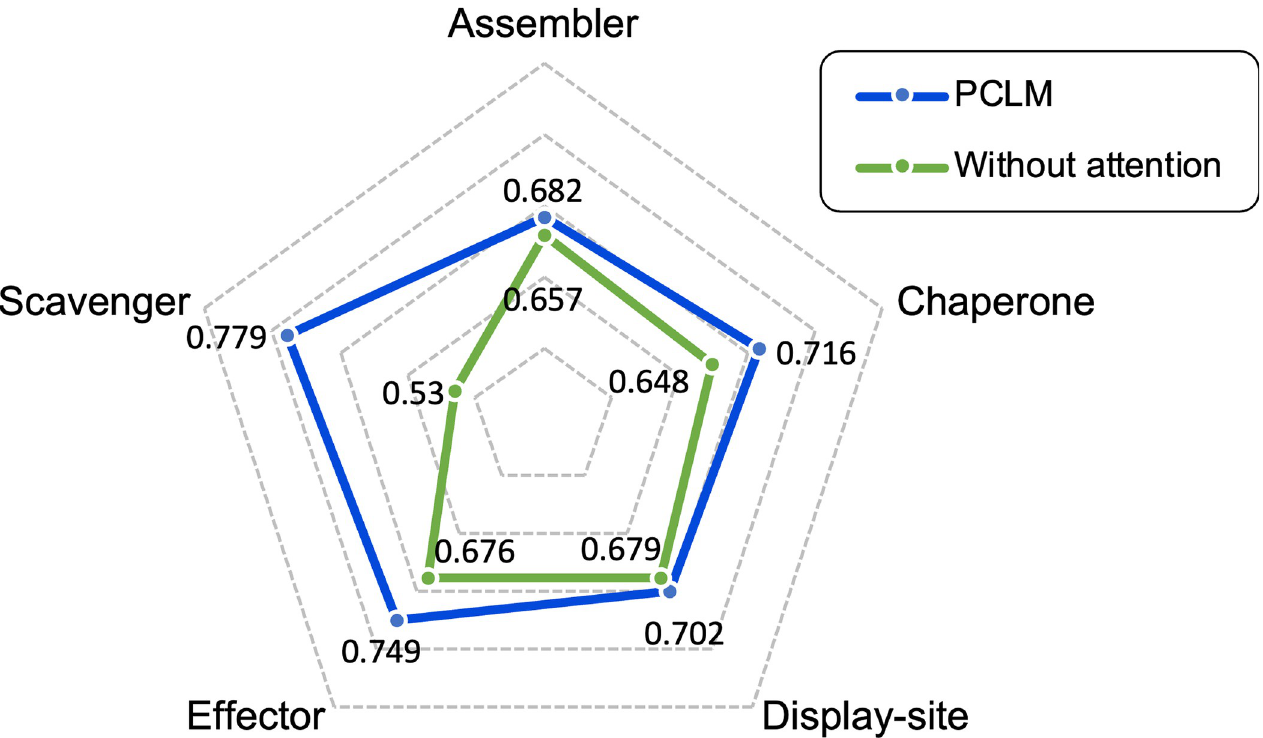
Fig 5. The predictive results (AUC values) of DMFpred with and without attention-based language model alignment. The PCLM represents the entire PCLM predictive model, while the Without attention denotes the PCLM model without the ALAN module. Both two models were independently fine-tuned and evaluated for the five molecular functions on the training dataset and validation dataset,